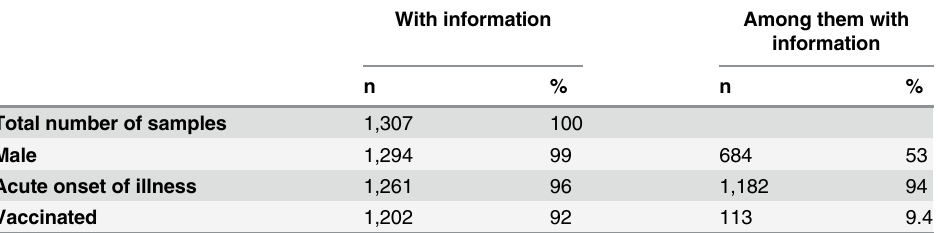
Table 1. Data characteristics of patients swabbed during the study period from week 40/2012 to 19/ 2013, Virological Surveillance, Saxony-Anhalt. With information Among them with information